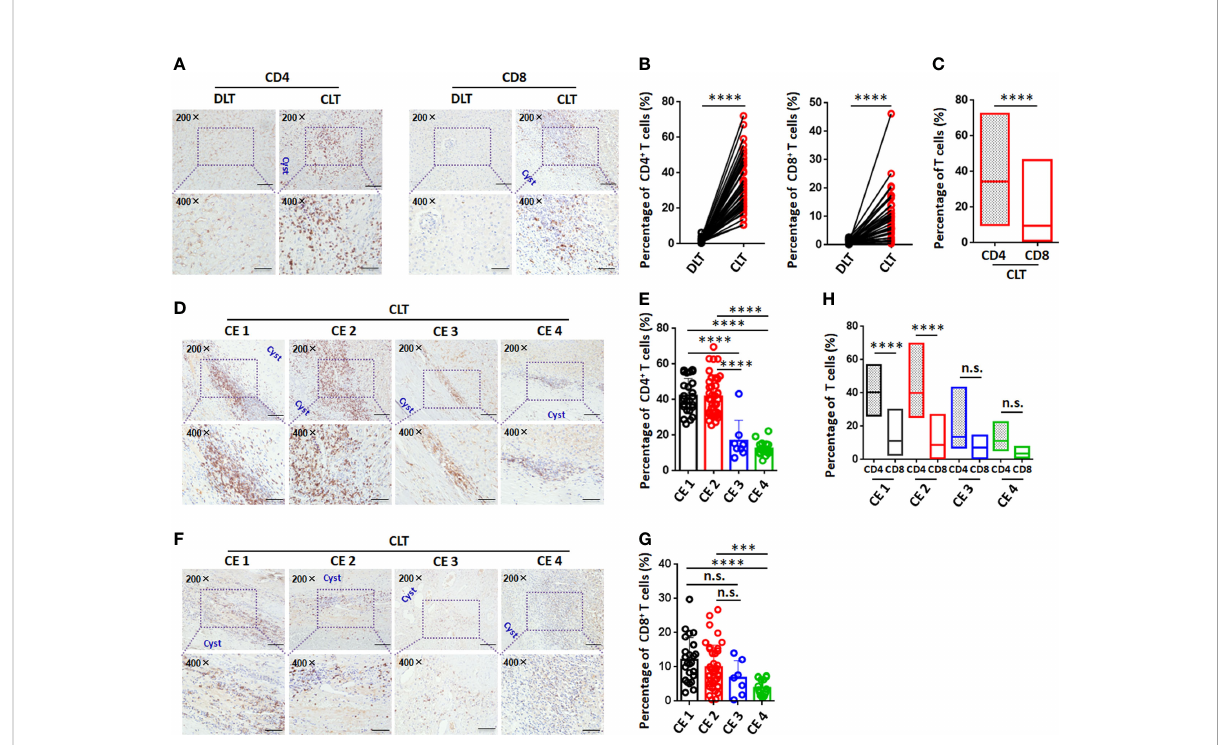
FIGURE 2 Immunohistochemical analysis of CD4 + T cells and CD8 + T cells in the liver in CE patients at different stages. (A) Representative images for CD4 and CD8 staining (upper panel 200×, enlarged 400× on the lower panel) on paired liver sections from CE patients. (B) Percentage of in fi ltrating CD4 + T cells or CD8 + T cells in paired liver tissue, from (A) (n=43). (C) Comparison of CD4 + T cells to CD8 + T cells percentage on CLT from CE patients. (D) Representative images for CD4 staining (upper panel 200×, enlarged 400× on the lower panel) on CLT from CE patients at different stages. (E) The percentage of in fi ltrating CD4 + T cells on CLT, from (D) (n=89). (F) Representative images for CD8 staining (upper panel 200×, enlarged 400× on the lower panel) on CLT from CE patients at different stages. (G) The percentage of in fi ltrating CD8 + T cells on CLT, from (F) (n=89). (H) Comparison of CD4 + T cells to CD8 + T cells percentage on CLT from CE patients at different stages. Data are expressed as mean ± SD, analyzed by Student ’ s t tests or one way ANOVA. *** P < 0.001, **** P < 0.0001, no signi fi cance(n.s.) P >